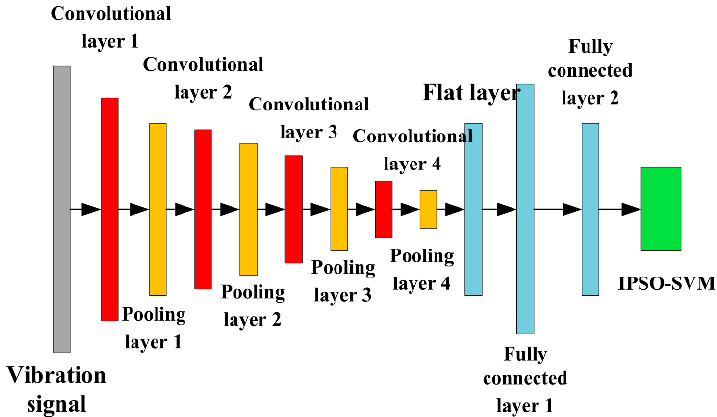
Figure 4. Workflow chart of gearbox fault diagnosis based on the 1DCNN-IPSO-SVM model.